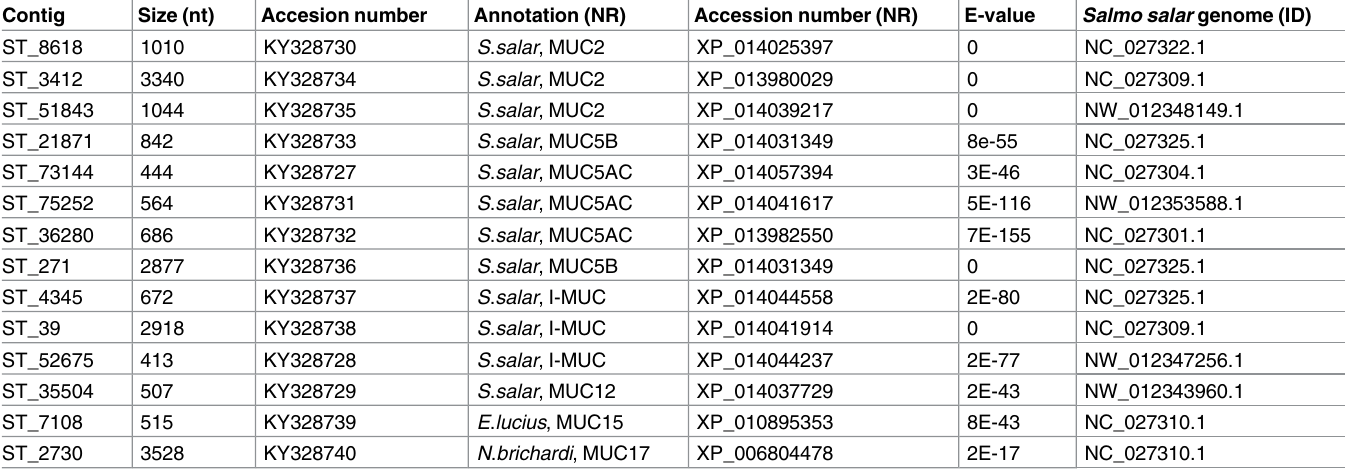
Table 4. Classification of the mucins identified in skin transcriptome, according to the BLASTX and BLASTN searches. Contig Size